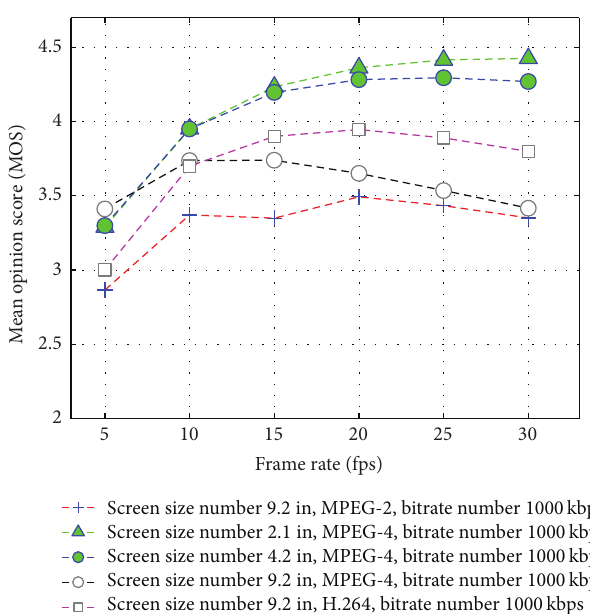
Figure 7: Estimated video quality on N-Screen devices versus frame rate.